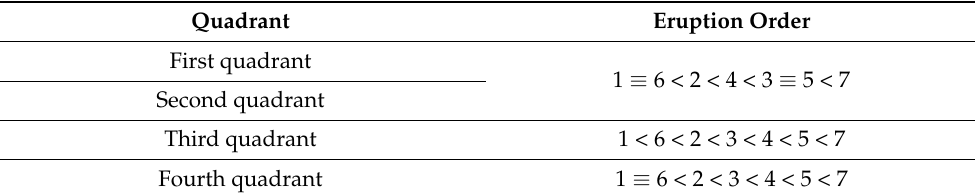
Table 2. Chronology of dental eruption by quadrant. Tooth 1 (central incisor), tooth 2 (lateral incisor), tooth 3 (canine), tooth 4 (first premolar), tooth 5 (second premolar), tooth 6 (first molar), tooth 7 (second premolar).